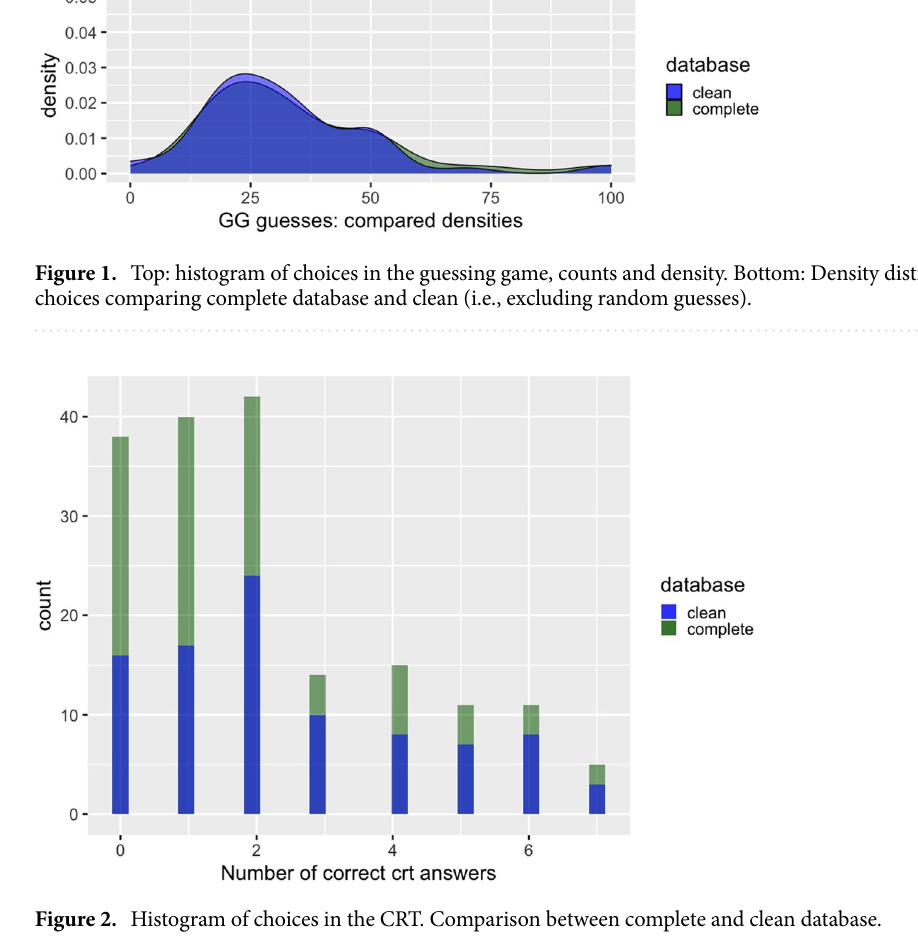
Figure 2. Histogram of choices in the CRT. Comparison between complete and clean